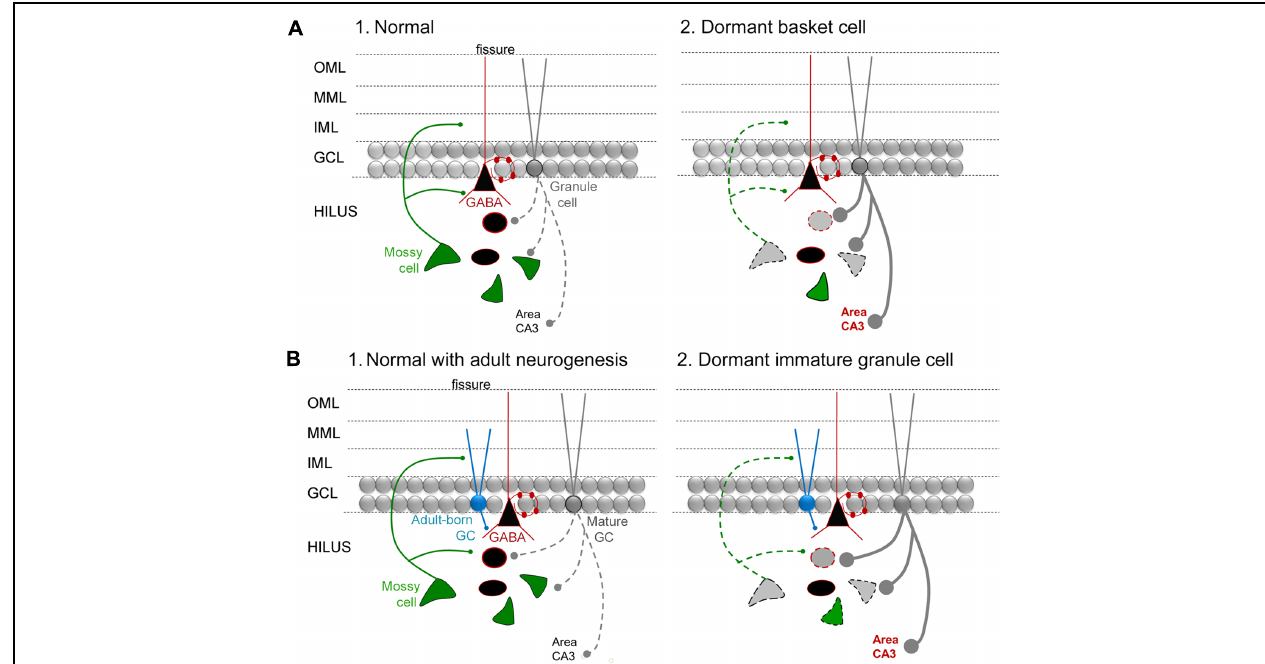
FIGURE 6 | The dormant immature GC hypothesis. (A) (1) A diagram of the circuitry of the normal DG is shown. The dotted line reflects the sparse firing of GCs that is considered an important characteristic of the normal DG. (2) The “dormant basket cell hypothesis” (Sloviter, 1991, 1994) proposes that MC loss in TLE (diagrammed by the light gray MC with a dotted line for its axon) leads to deafferentation of basket cells (reflected by the black triangular cell with a red outline) and consequent disinhibition of GCs (reflected by a thick gray line for the axon, with large boutons). Cell loss in TLE includes the MCs and other hilar GABAergic neurons (gray cell bodies with dotted outlines). The red type